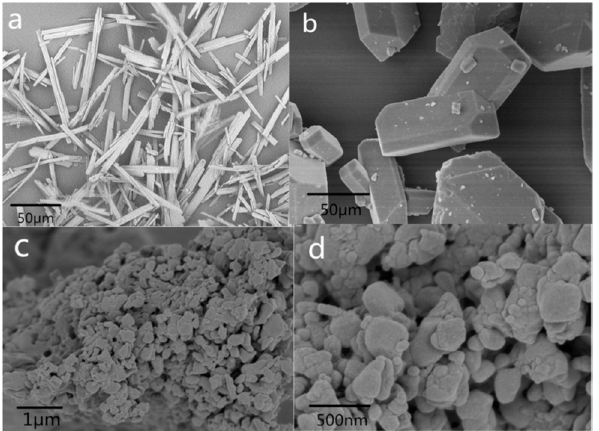
Figure 10. SEM of ( a ) NQ, ( b ) CL ‐ 20, and ( c , d ) CL ‐ 20/NQ nano cocrystals. Reproduced from [78], with permission from Propellants Explos. Pyrotech., 2017. Table 2. Mechanical sensitivity of different EMs compared to that of corresponding micro ‐ sized EMs.